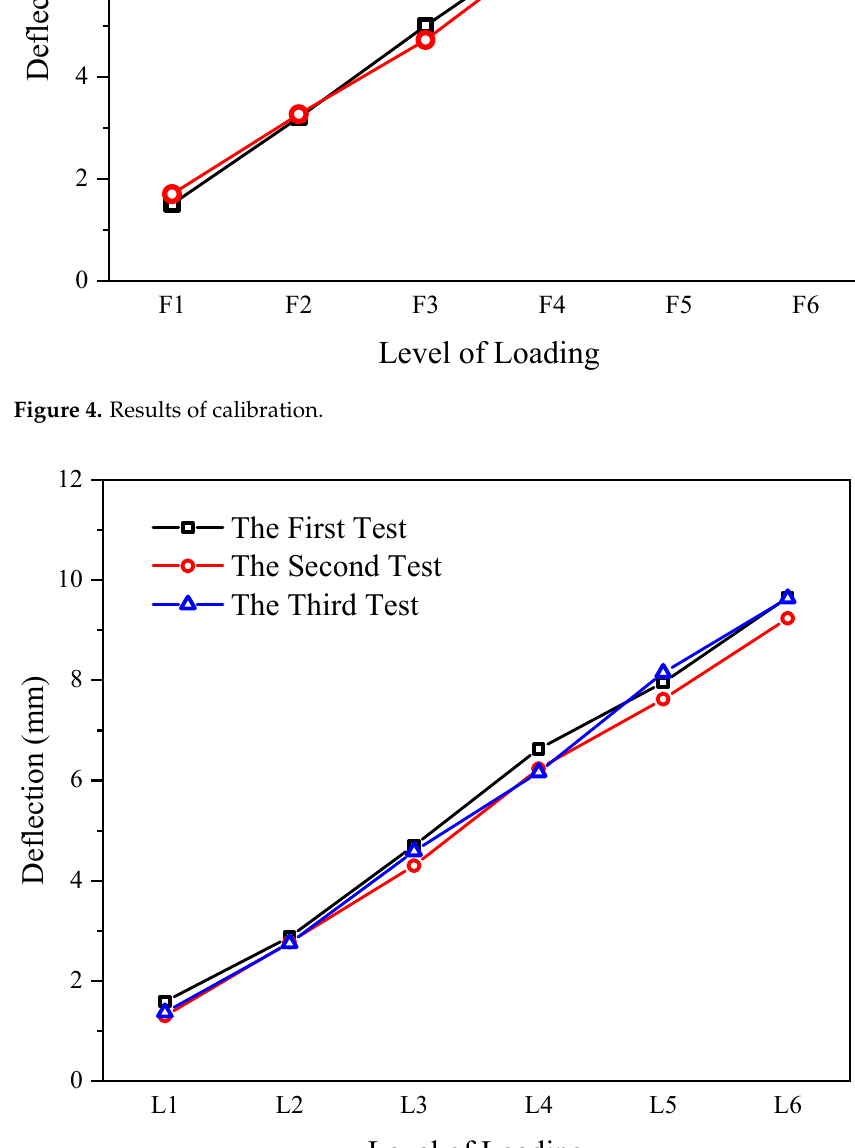
Figure 5. Deflection values under cyclic loading.